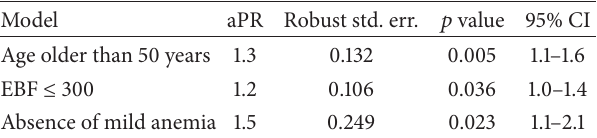
Table 2: Cardiovascular disease: robust Poisson regression